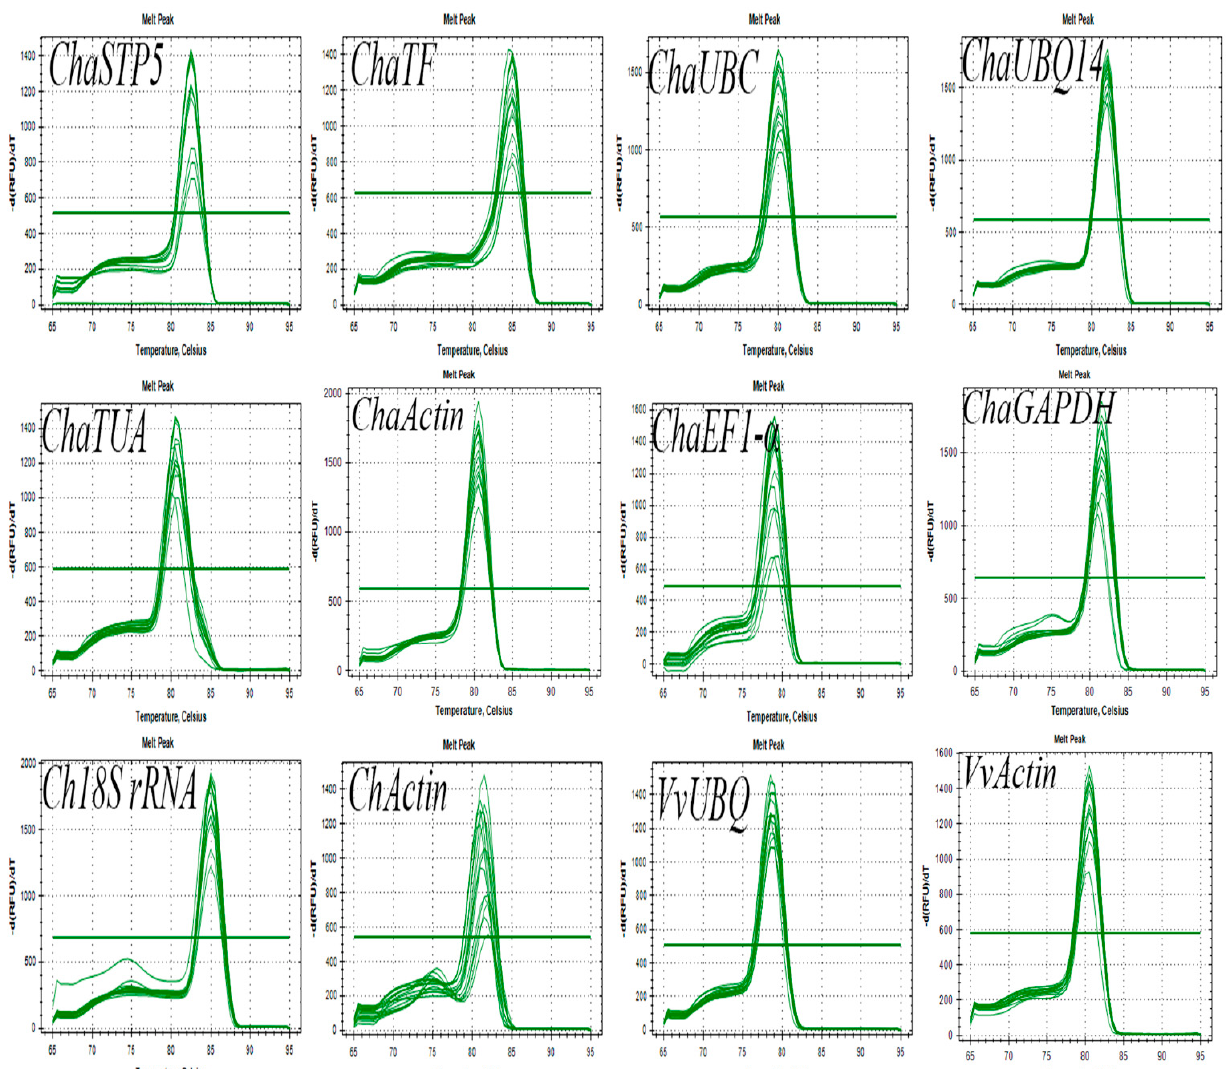
Figure 2. Melt curve analyses of RT-qPCR products for 12 candidate reference genes.